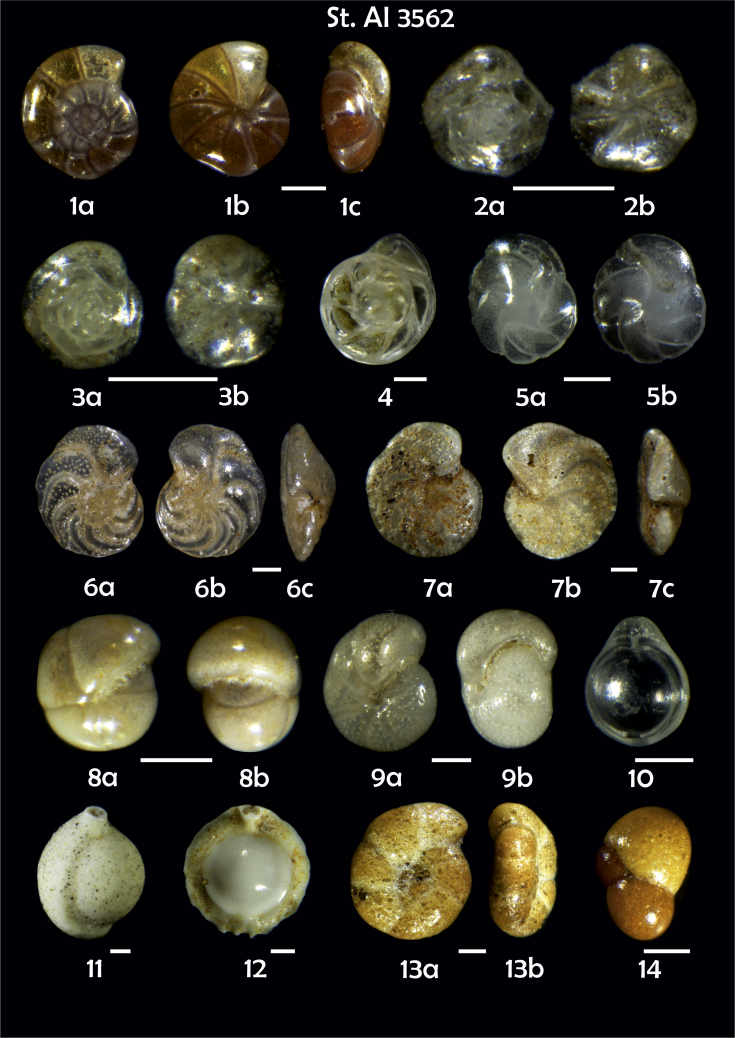
Station 35621Gyroidina orbicularis, a spiral view, b umbilical view, c apertural view. 2Epistominella exigua, a spiral view, b umbilical view. 3Alabaminella weddellensis, a spiral view, b umbilical view. 4Hoeglundina elegans. 5Cassidulina teretis, a apertural view, b lateral view. 6, 7Cibicidoides wuellerstorfi, a umbilical view, b spiral view, c apertural view. 8Pullenia bulloides, a side view, b apertural view. 9Melonis pompilioides, a side view, b apertural view. 10Fissurina sp. 11Pyrgo sp. 12Pyrgo murrhina. 13Recurvoidatus? sp., a umbilical view, b apertural view. 14Cystammina pauciloculata. Scale 100 μm.